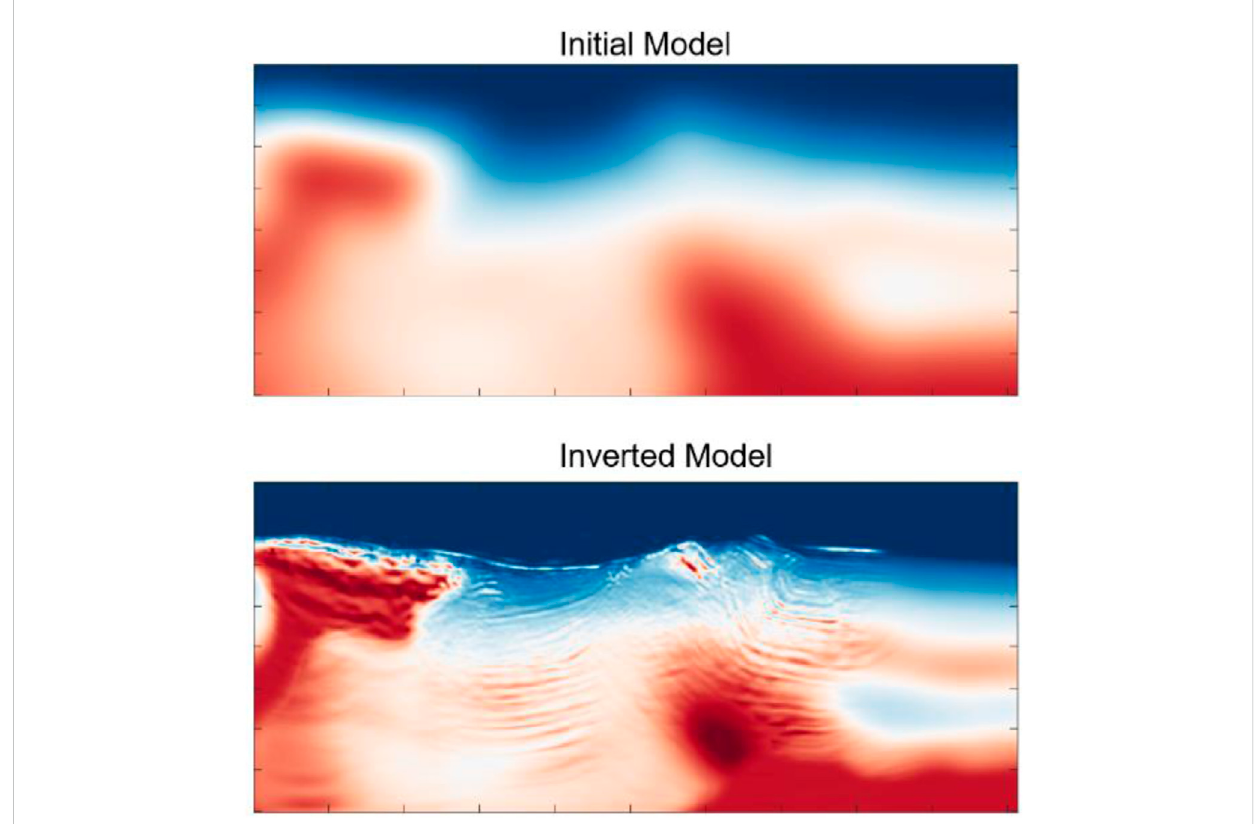
FIGURE 10 Initial model and fi nal inverted velocity model. Compared with the initial model, the shapes of the salt body have been well updated. In addition, some detailed layered structures are also recovered.